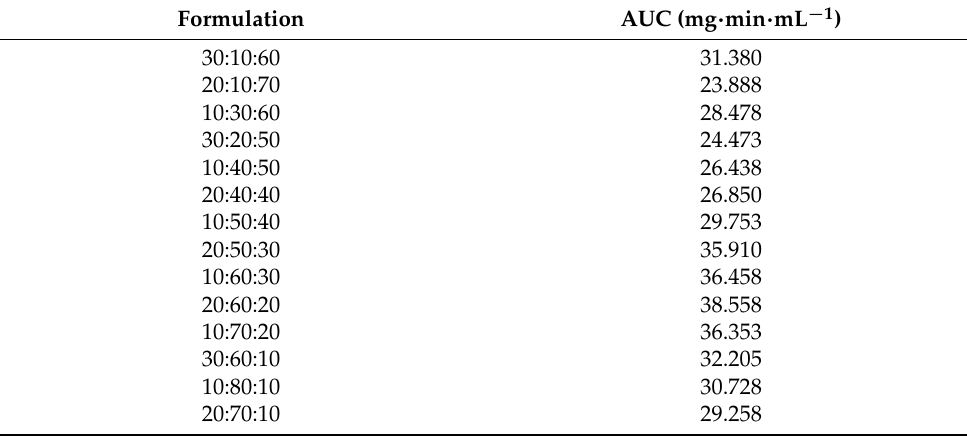
Table 6. AUC of saturated SNEDDS formulations after dilution with distilled water.